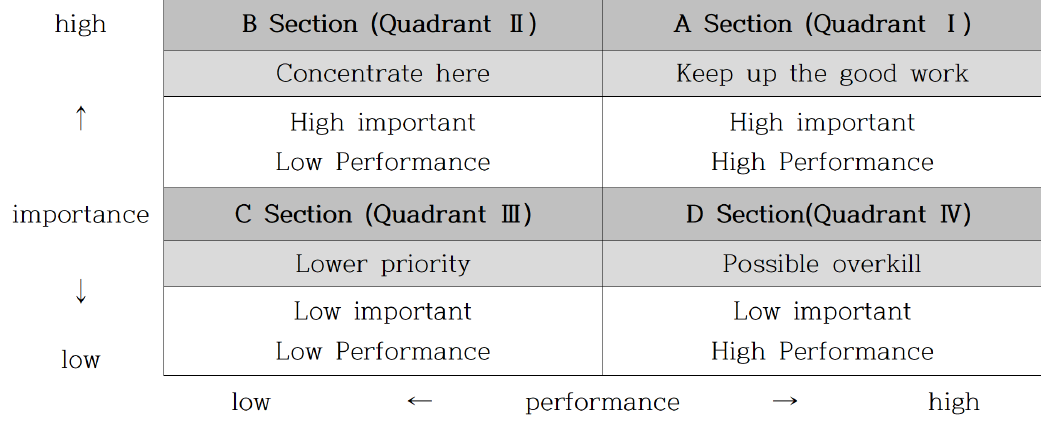
Fig. 1. Importance – Performance Matrix [32].